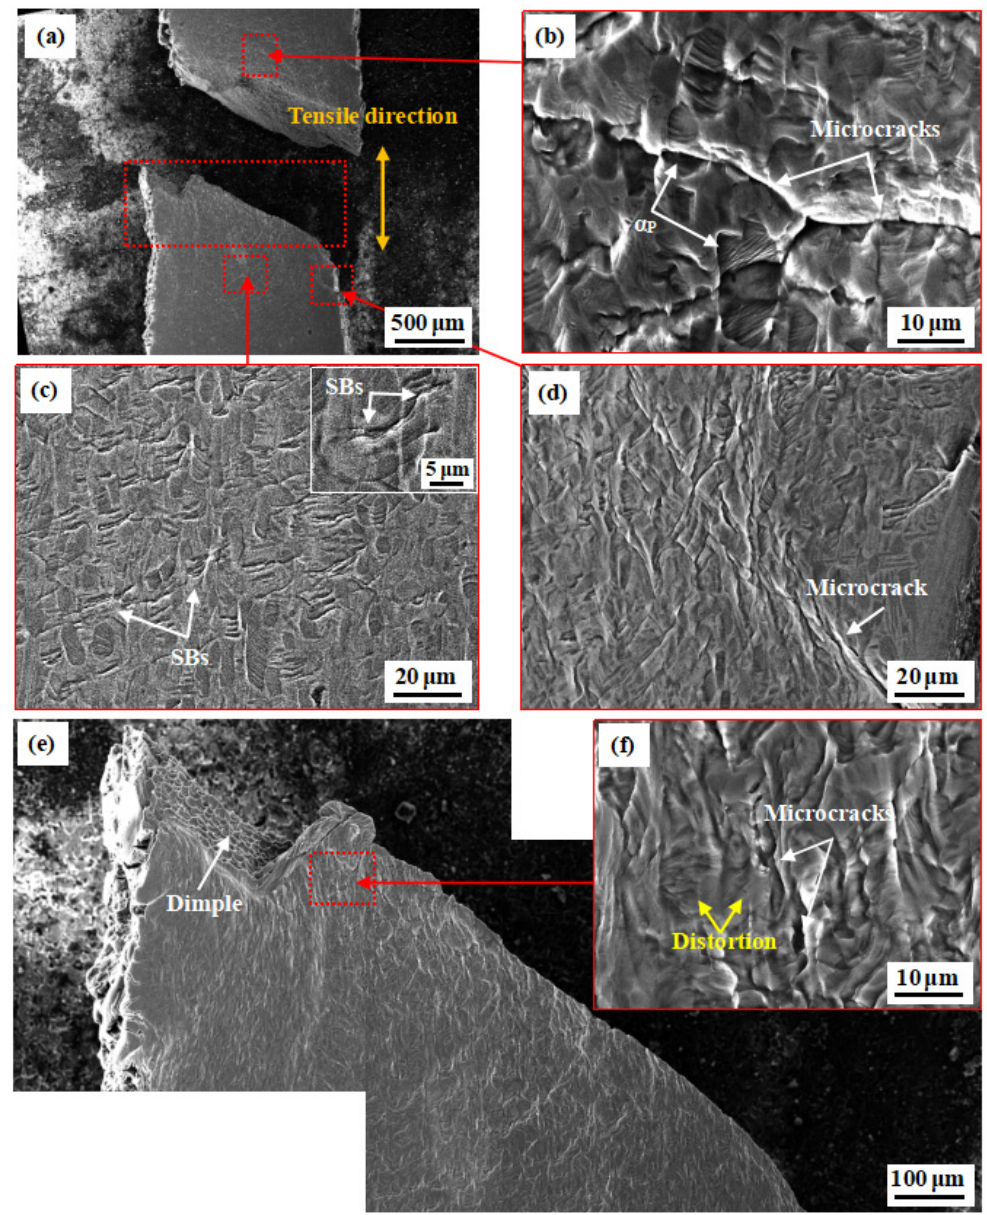
Figure 7. ( a ) In situ SEM images of bimodal microstructure sample at F (the displacement of 1012 µ m); ( b ) a crack propagated along the SBs in the α P phase; ( c ) SBs in each α P phase tended to interconnect; ( d ) magnified image showing microcracks formed on the edge of the sample; ( e ) SEM images showing the rough fracture surface of the sample; ( f ) magnified image showing many microcracks existed near the fracture area.